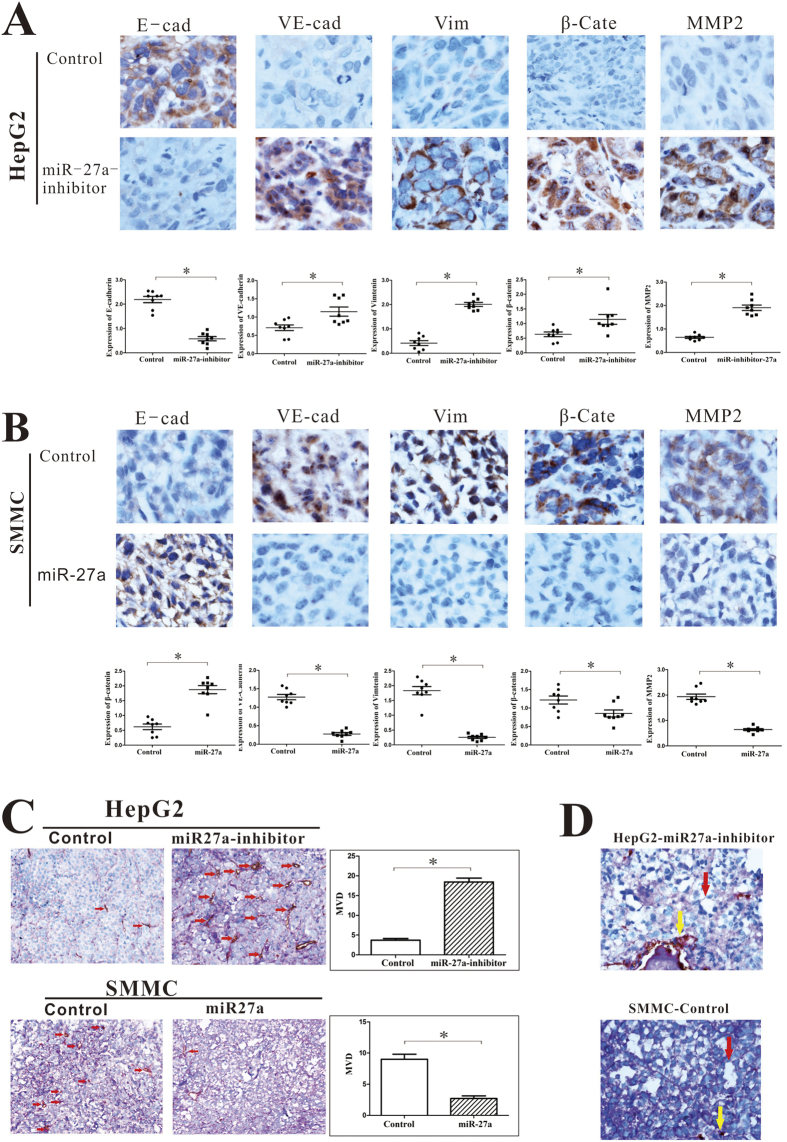
miR-27a-3p inhibits VM formation and metastasis by regulating EMT in vivo.HepG2 cells stably transfected with the miR-27a-3p inhibitor (miR-27a-inhibitor) and SMMC cells stably transfected with miR-27a-3p (miR-27a) were subcutaneously injected into BALB/c-nu/nu mice. IHC staining showed the expression of E-cadherin (E-cad), VE-cadherin (VE-cad), vimentin (Vim), β-catenin (β-cate) and MMP2 from the group transfected with the HepG2-miR-27a-inhibitor (A) and SMMC cells transfected with miR-27a (B,C) Endomucin/PAS double staining showed MVD based on endomucin staining (red arrows indicate MVD) (D). Endomucin/PAS double staining showed VM formation in HCC tissue (red arrows indicate capillary tubules formed by tumor cells; yellow arrows indicate endothelium-dependent vessels).